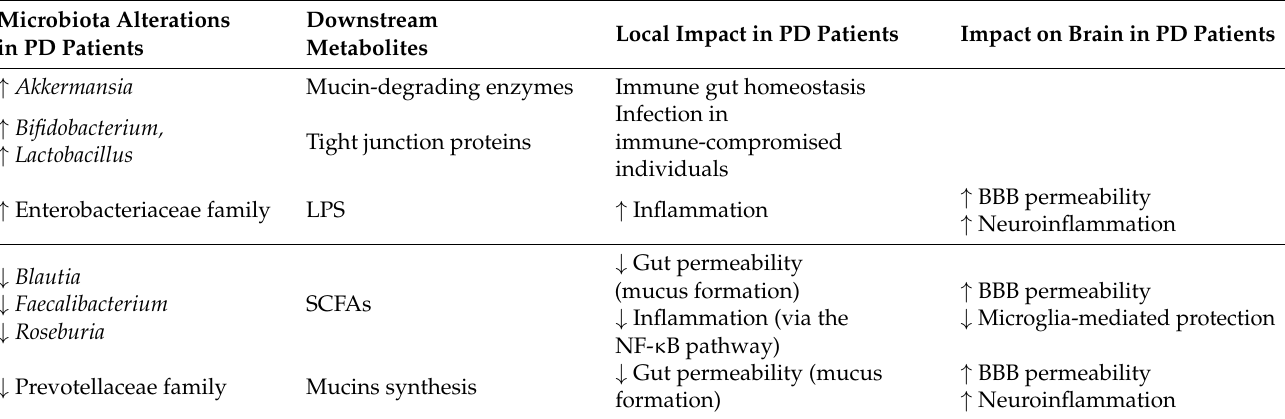
Table 1. Most consistent microbiota alterations measured in PD patients with respect to healthy individuals (from